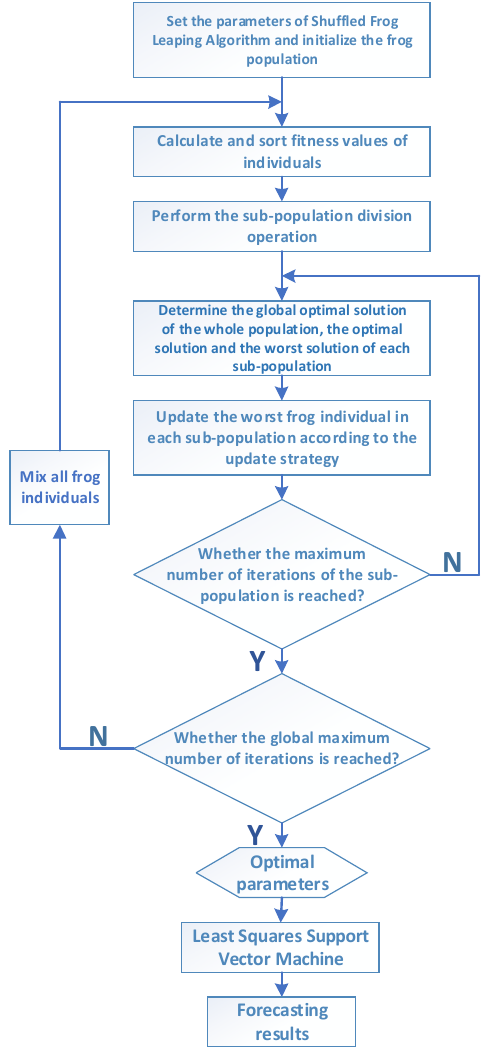
Figure 2. The flowchart of Improved Shuffled Frog Leaping Algorithm (ISFLA-LSSVM). 2.5. The Forecasting Model Based on Ensemble Empirical Mode Decomposition and Least Squares Support Vector Machine Optimized by Improved Shuffled Frog Leaping Algorithm (EEMD-ISFLA-LSSVM)